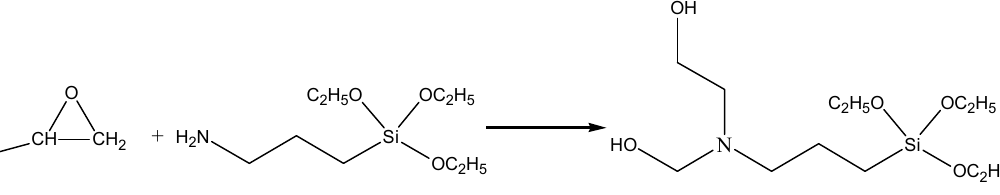
Figure 2. The reaction principle of epoxy group and LT-550.